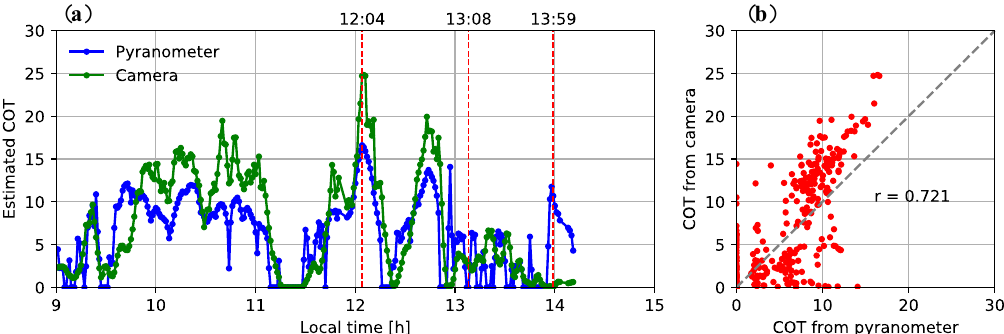
Figure 14. Comparison of the average COT estimated from a zenith-oriented digital camera using the CNN, and the COT estimated using a pyranometer, for 11 November 2018, as follows: ( a ) time series with a one-minute interval; ( b ) a scatter plot of the COT estimated by the two methods. For the camera-based estimation, the COT values were converted from the SCOT obtained for every pixel, and averaged over a field within 43° from the center of the image. In ( a ), the three red dashed lines correspond to the times of Figure 13a,b,c, respectively. In ( b ), the correlation coefficient ( r ) is shown.